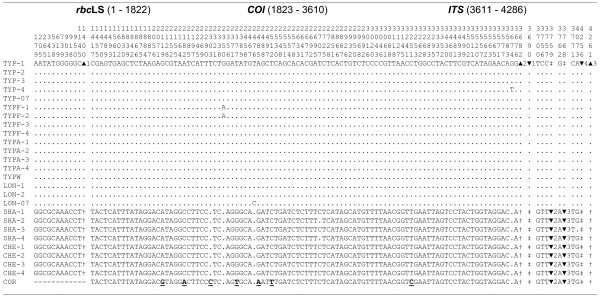
Nucleotide substitution sites in the rbc LS, COI , and ITS gene regions of the Saccharina japonica morphological forms.  The numbers above the top sequence represent the position of segregating sites and the start of a deletion or insertion (see also Additional file 4). Nucleotides are numbered from the beginning of our sequence. Dots indicate the same nucleotide as the reference sequence. The hyphens represent deleted nucleotides. ▴ denotes a deletion; † denotes the absence of a deletion; ▼ denotes an insertion; ‡ denotes the absence of an insertion. The sample abbreviations are in the section "Methods". COR: S. coriacea. The underlined nucleotides in bold face show fixed differences between COR and the other sequences.